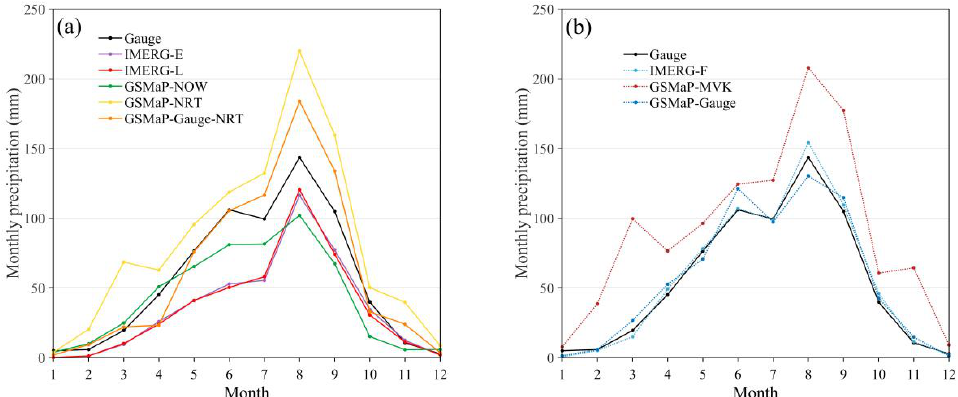
Figure 7. Comparison of SPP-based mean monthly precipitation with the ground observations: ( a ) real-time and near-real-time SPPs and ( b ) post-real-time SPPs